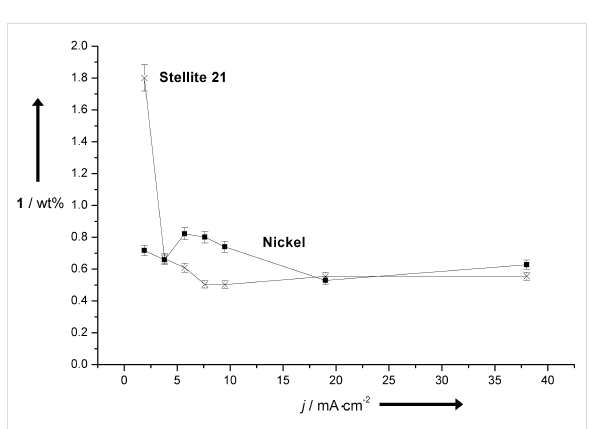
the concomitant formation of Co oxides found as dark coating on the electrode surface as well as suspended to a small extent in the electrolyte.